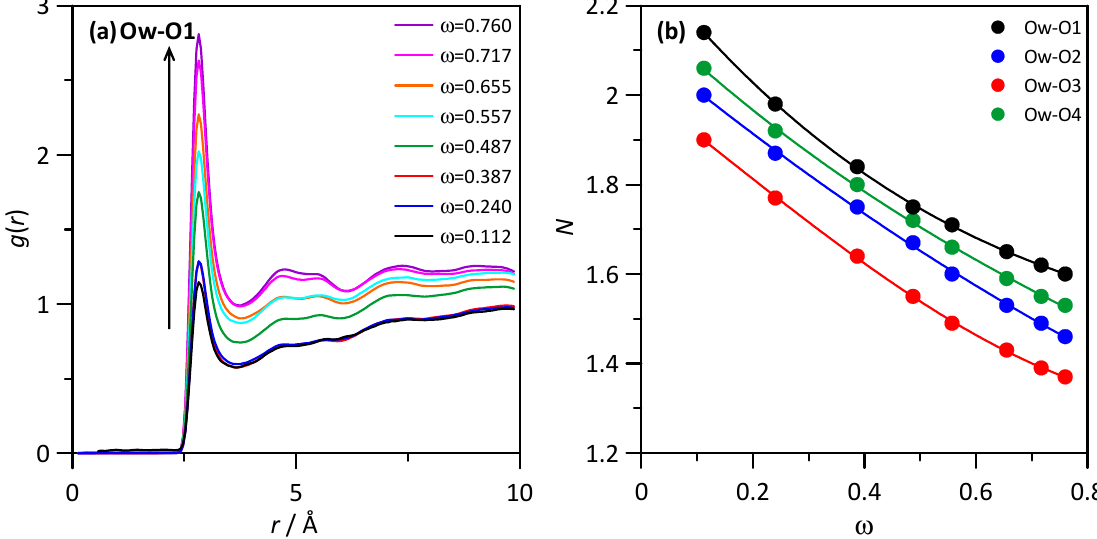
Figure 8. ( a ) Site-site radial distribution functions, g ( r ), and ( b ) running integrals, N , for the reported atomic pairs in ω THAL + (1- ω ) water mixture at 310 K. The arrow indicates increasing ω . Atom labelling as in Figure 1.